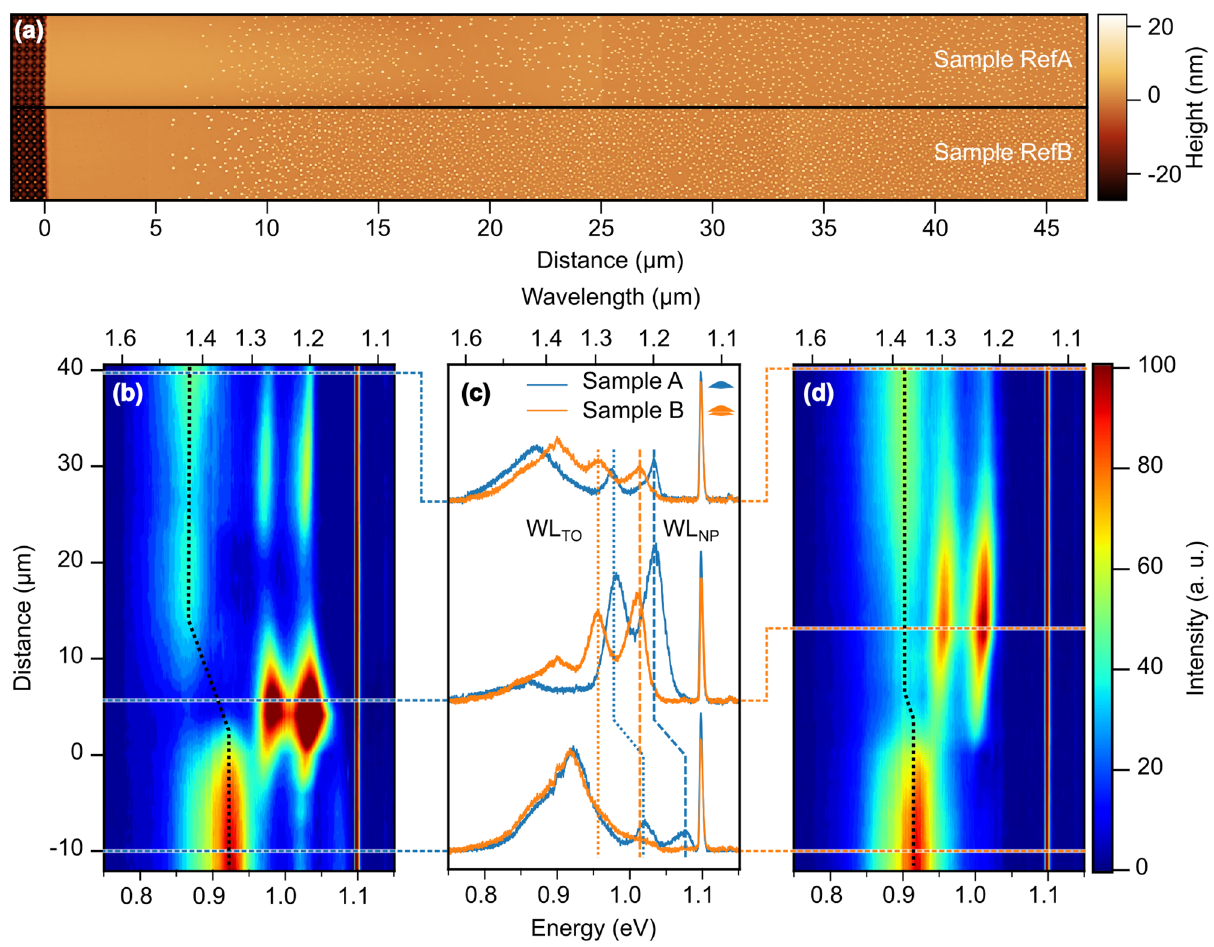
origin of the distance scale, with positive values pointing into the plain substrate area. In both samples, a denuded zone free of QDs is observed in the first 5 µ m to 7 µ m of the plain area, followed by random QD nucleation with a bimodal shape distribution of pyramid- and dome-shaped QDs. ( b ), ( d ): Photoluminescence contour plots of sample A and B, respectively, on the same distance scale as in ( a ). As a guide to the eye, the dotted vertical lines indicate the respective shifts of the QD signals from the patterned to the plain areas. ( c ) Comparison of PL spectra of the two samples from the ordered field, the denuded zone and the randomly nucleated area (bottom to top), as indicated by the horizontal dashed lines in ( b ), ( d ). The dashed vertical lines indicate the energetic shifts of the respective WL-signal peaks. All spectra were recorded at 10K. For more details see the Suppl.